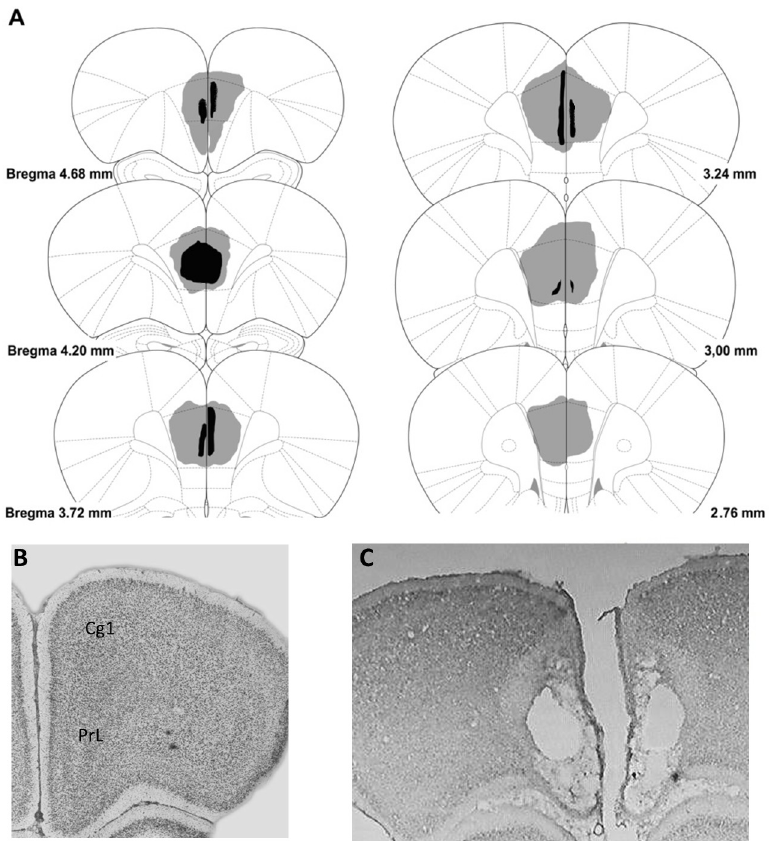
Fig 1. A. Reconstruction of the mPFC lesions displayed on standard coronal sections from the atlas of Paxinos and Watson [28] . The largest lesion is shown in pale shading and the smallest in dark shading. B. Photomicrograph showing a no lesioned coronal brain section. C. A coronal section after excitotoxic lesion of mPFC. Cg1: cingulate cortex, area 1; PrL: prelimbic